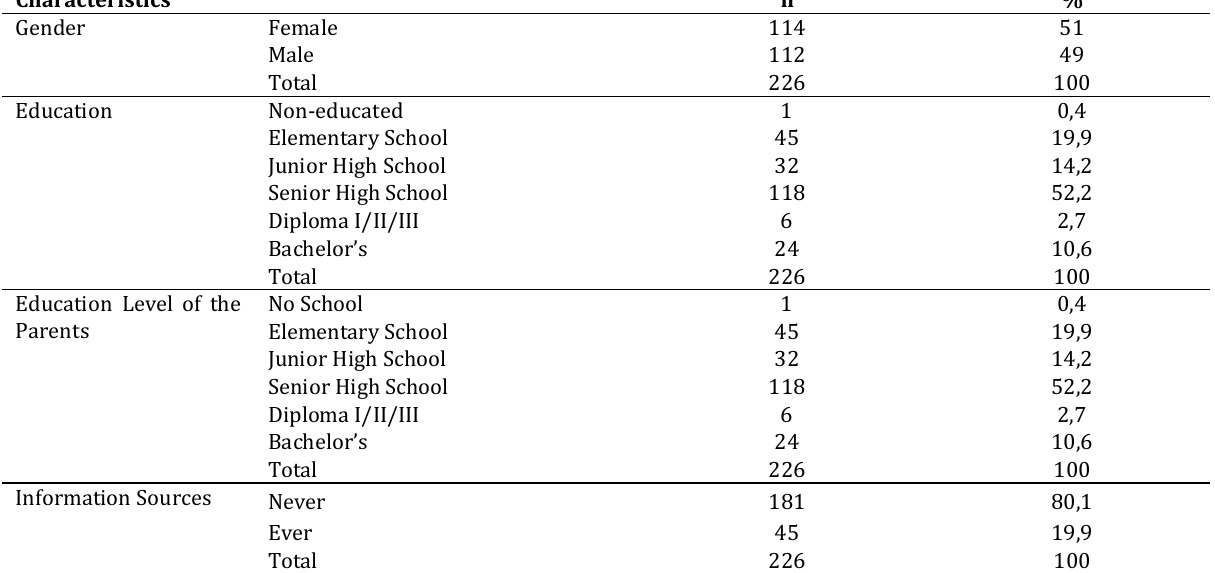
Table 1. Characteristics of the Respondents at SMKN 3 Banjarbaru